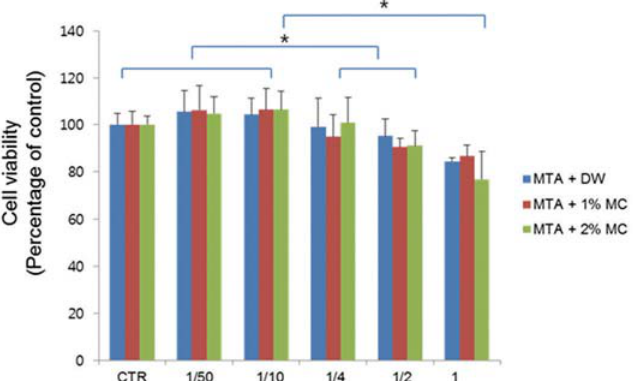
Figure 1- (cid:3)(cid:55)(cid:75)(cid:72)(cid:3)(cid:192)(cid:82)(cid:90)(cid:68)(cid:69)(cid:76)(cid:79)(cid:76)(cid:87)(cid:92)(cid:3)(cid:82)(cid:73)(cid:3)(cid:87)(cid:72)(cid:86)(cid:87)(cid:3)(cid:80)(cid:68)(cid:87)(cid:72)(cid:85)(cid:76)(cid:68)(cid:79)(cid:86)(cid:17)(cid:3)(cid:55)(cid:75)(cid:72)(cid:3)(cid:192)(cid:82)(cid:90)(cid:68)(cid:69)(cid:76)(cid:79)(cid:76)(cid:87)(cid:92)(cid:3)(cid:82)(cid:73)(cid:3)(cid:48)(cid:55)(cid:36)(cid:3)(cid:80)(cid:76)(cid:91)(cid:72)(cid:71)(cid:3)(cid:90)(cid:76)(cid:87)(cid:75)(cid:3)(cid:20)(cid:8)(cid:3)(cid:68)(cid:81)(cid:71)(cid:3)(cid:21)(cid:8)(cid:3)(cid:48)(cid:38)(cid:18)(cid:38)(cid:68)(cid:38)(cid:79) (cid:80)(cid:76)(cid:91)(cid:72)(cid:71)(cid:3)(cid:90)(cid:76)(cid:87)(cid:75)(cid:3)(cid:71)(cid:76)(cid:86)(cid:87)(cid:76)(cid:79)(cid:79)(cid:72)(cid:71)(cid:3)(cid:90)(cid:68)(cid:87)(cid:72)(cid:85)(cid:17)(cid:3)(cid:39)(cid:76)(cid:73)(cid:73)(cid:72)(cid:85)(cid:72)(cid:81)(cid:87)(cid:3)(cid:79)(cid:72)(cid:87)(cid:87)(cid:72)(cid:85)(cid:86)(cid:3)(cid:85)(cid:72)(cid:83)(cid:85)(cid:72)(cid:86)(cid:72)(cid:81)(cid:87)(cid:3)(cid:86)(cid:87)(cid:68)(cid:87)(cid:76)(cid:86)(cid:87)(cid:76)(cid:70)(cid:68)(cid:79)(cid:79)(cid:92)(cid:3)(cid:86)(cid:76)(cid:74)(cid:81)(cid:76)(cid:191)(cid:70)(cid:68)(cid:81)(cid:87)(cid:3)(cid:71)(cid:76)(cid:73)(cid:73)(cid:72)(cid:85)(cid:72)(cid:81)(cid:70)(cid:72)(cid:86)(cid:3)(cid:69)(cid:72)(cid:87)(cid:90)(cid:72)(cid:72)(cid:81)(cid:3)(cid:87)(cid:75)(cid:72)(cid:3)(cid:87)(cid:72)(cid:86)(cid:87)(cid:72)(cid:71)(cid:3)(cid:80)(cid:68)(cid:87)(cid:72)(cid:85)(cid:76)(cid:68)(cid:79)(cid:86)(cid:3)(cid:11)(cid:83)(cid:31)(cid:17)(cid:19)(cid:24)(cid:12)